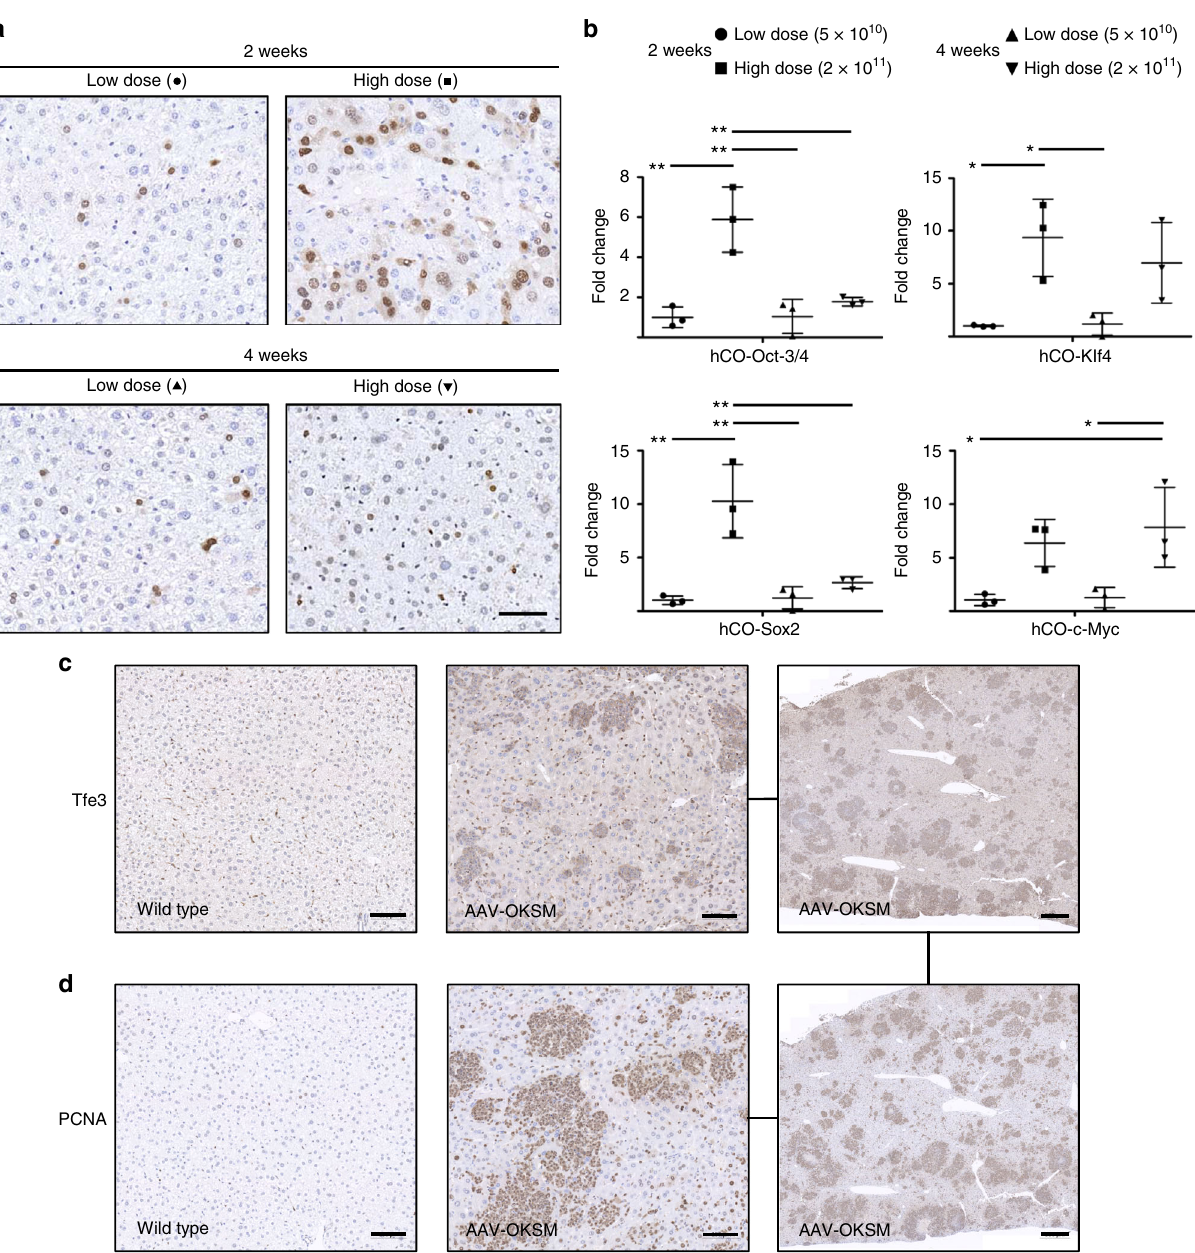
Fig. 3 Expression of the four reprogramming factors and evidence for reprogramming in mouse liver. a Detection of AAV-encoded hCO-Oct-3/4 (brown staining) via immunohistochemistry in liver sections obtained from mice 2 or 4 weeks post-injection with 5 × 10 10 (low dose) or 2 × 10 11 (high dose) vg per vector and mouse ( n = 3 per dose and time point). Symbols are the same as in b . Nuclei were counterstained with hematoxylin. Scale bar = 100 µ m. b Quanti fi cation of the expression of AAV-encoded hCO-Oct-3/4, -Klf4, -Sox2 and -c-Myc by qRT-PCR. A delta Ct analysis was used in which the values were normalized to the expression of a housekeeper gene (actin) and then expressed as fold-changes over the values (set to 1) for the low dose at 2 weeks for each reprogramming factor. Each point represents a single mouse. Center values are means and error bars are S.D. Statistical analyses were performed by one-way ANOVA with Tukey ’ s Multiple Comparison Test. *, p < 0.05; **, p < 0.01. c , d Evidence for reprogramming in livers of AAV-OKSM-treated mice (2 × 10 11 vg, sacri fi ced 8 weeks after administration) obtained via immunohistochemical detection of expression of Tfe3 ( c ), a marker for pluripotency, and PCNA ( d ), a marker for proliferation. Note the largely overlapping patches of Tfe3- and PCNA-positive cells in the serial sections from the same liver of an AAV-OKSM-treated mouse in the rightmost panels. Scale bars in the left and central panels = 100 µ m, and in the right panels = 500 µ